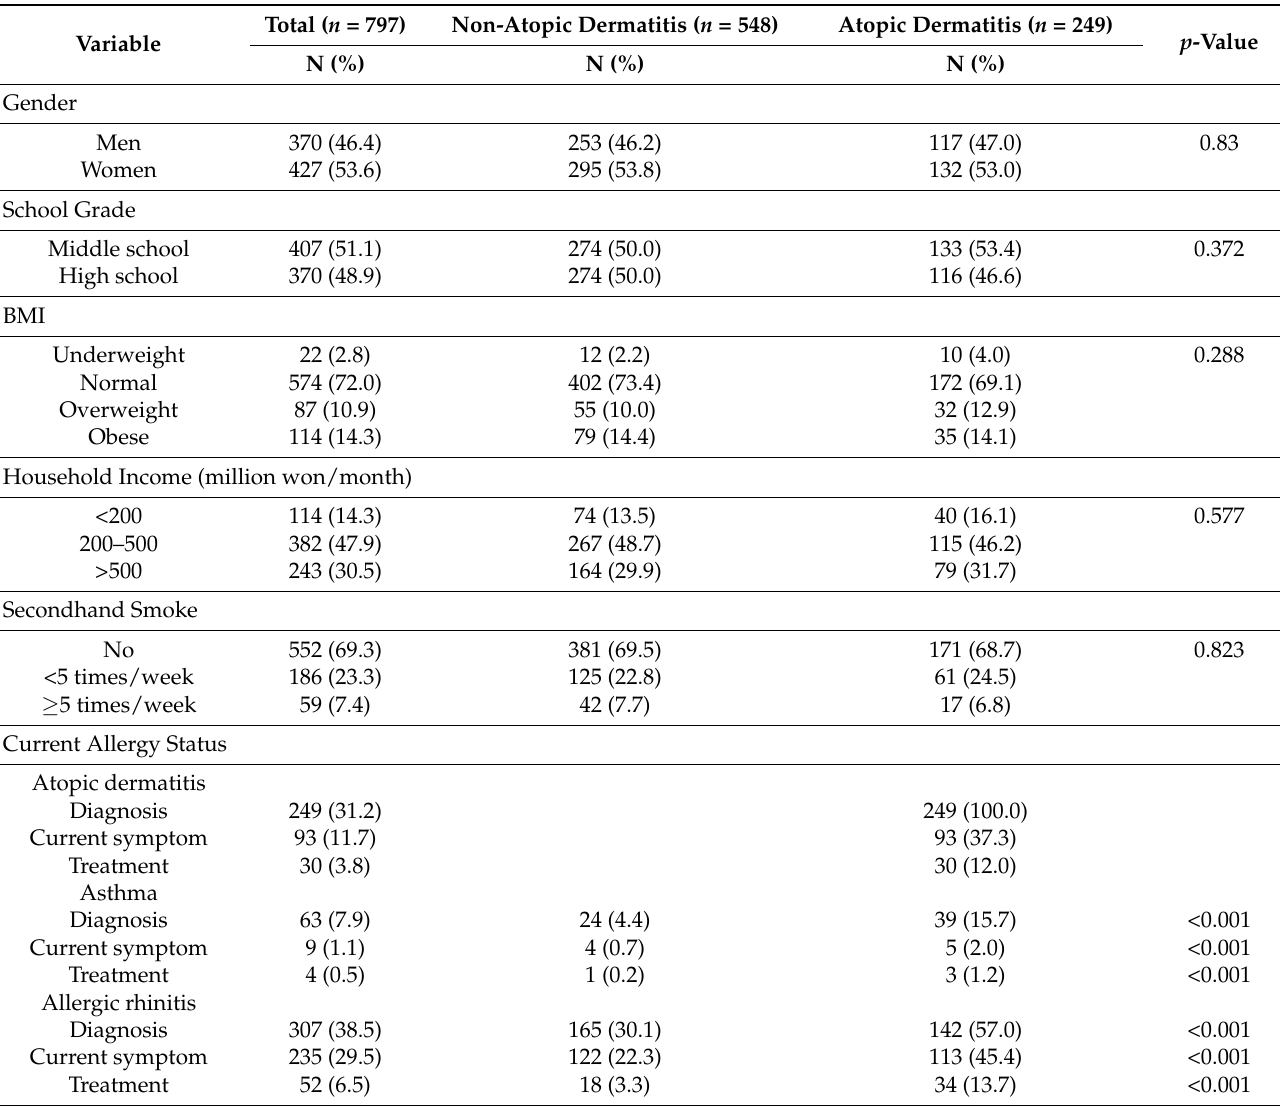
Table 2. Demographic characteristics and current allergic status of the subjects in the atopic dermatitis and non-atopic dermatitis groups participating in Korean National Environmental Health Survey (KoNEHS) (2015–2017).